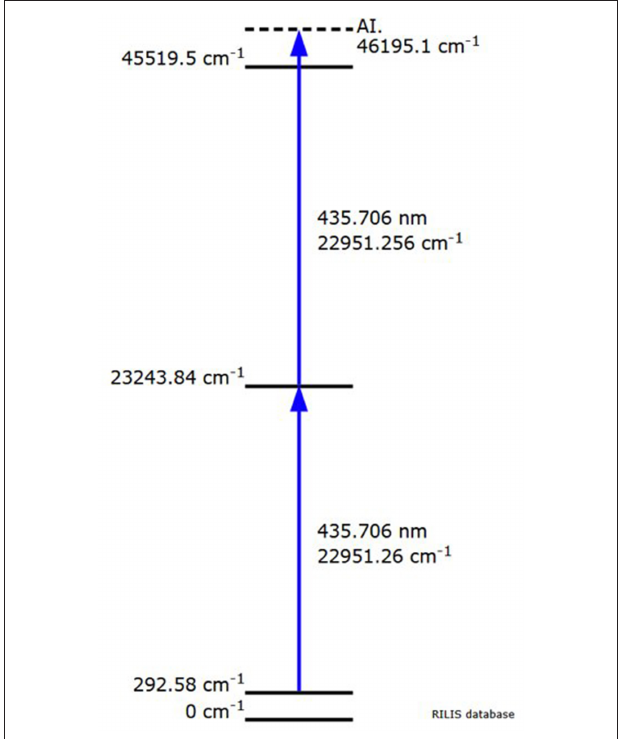
FIGURE 3 | Resonant laser ionization from the low-lying E = 292.6 cm − 1 state of samarium via two subsequent λ vac = 435.706nm transitions into an auto-ionizing state (RILIS database).